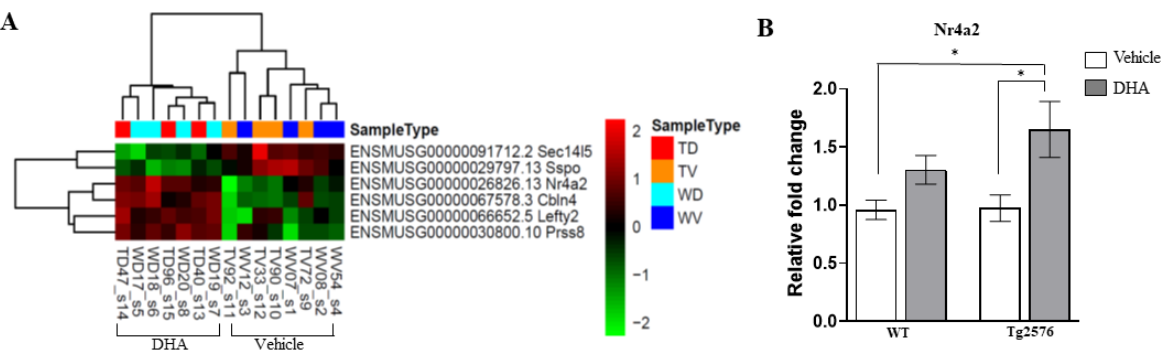
Figure 3. Common genes differentially expressed between vehicle and DHA treatment in both wild- type and Tg2576 mice. ( A ) Differentially expressed genes clusters upon DHA (D) treatment in wild- type (W) and Tg2576 (T) mice. ( B ) The mRNA expression level of Nr4a2 was assessed by qRT-PCR. Results are expressed as mean ± SEM (n = 4–8 per group). Two-way analysis of variance (ANOVA) and Tukey’s post hoc test was used for statistical analyses, * p ≤ 0.05.